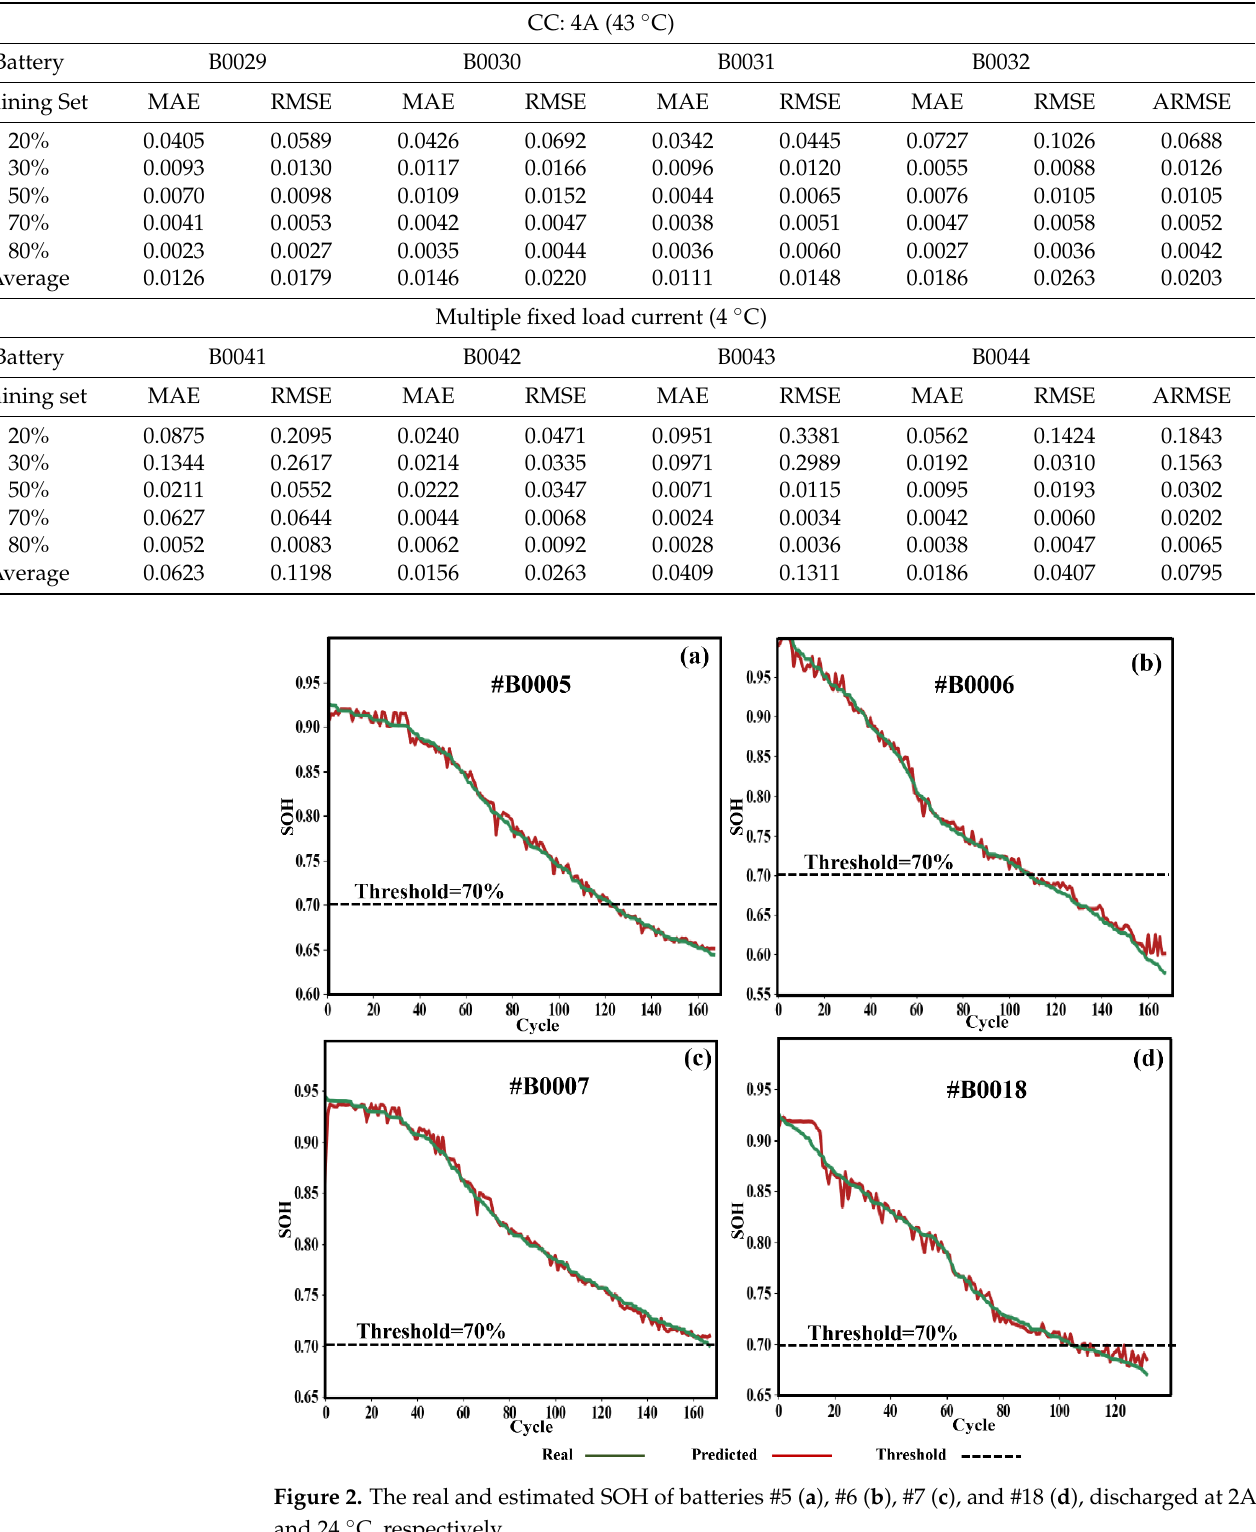
Table 3. The values of the MAE, RMSE, and ARMSE of the SOH estimation using the SR model on batteries discharged at different currents and temperatures (43 ◦ C and 4 ◦ C).